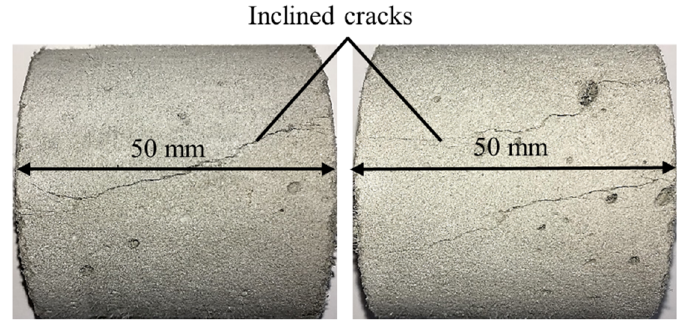
Figure 7. Two examples of crack pattern on the surfaces of M1-6PE specimens with a length of 50 mm tested under quasi-static compression.